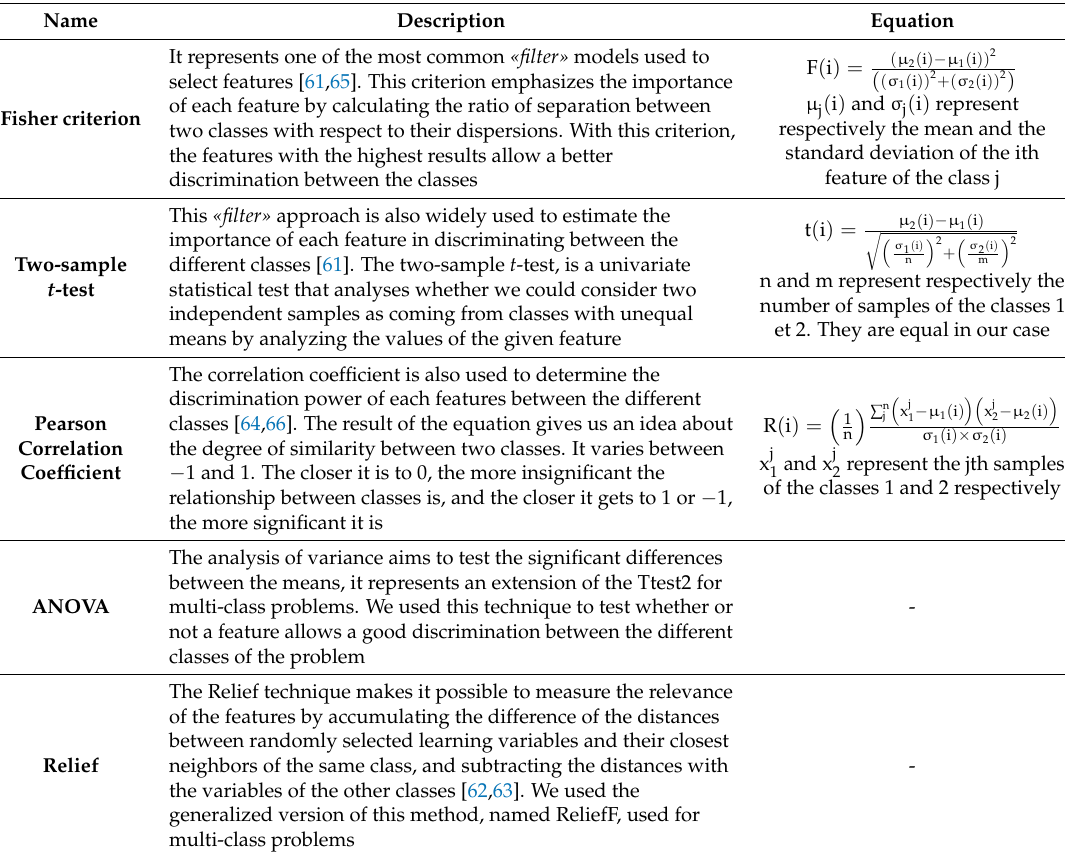
Table 4. The filter techniques and their